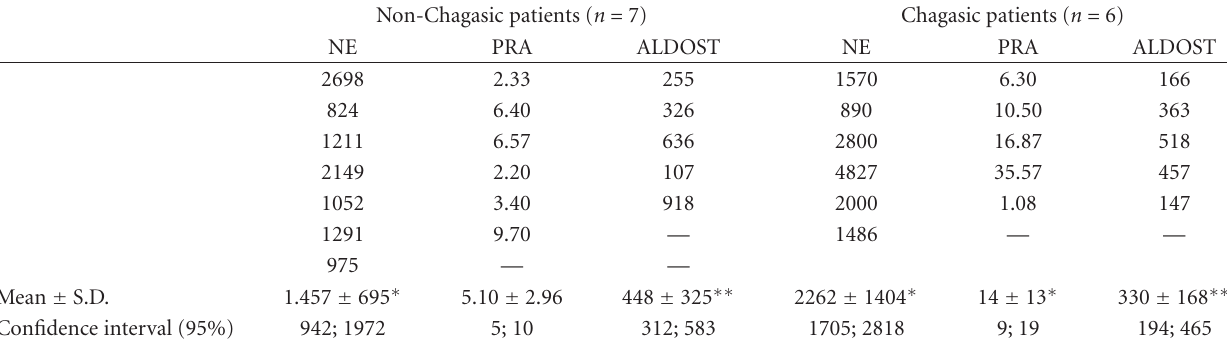
Table 2: Baseline serum levels of norepinephrine, plasma renin activity, and aldosterone in chagasic and non-chagasic patients with advanced congestive heart failure. The baseline serum levels of norepinephrine (NE), plasma renin activity (PRA), and aldosterone (ALDOST) of the chagasic patients were not di ff erent from those of the non-chagasic patients (see [36], with permission from Elsevier).